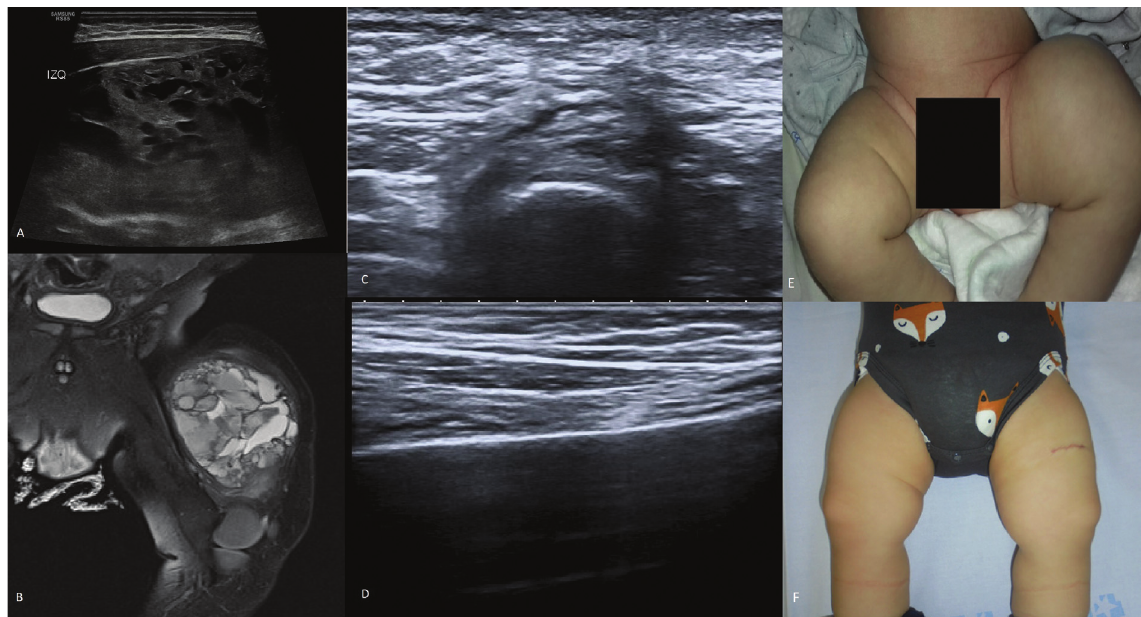
Fig. 2 (A) Ultrasound of the left lower limb with fi ndings suggestive of possible hematoma of the muscle. (B) MRI shows soft tissue tumor of the left lower limb. (C) and (D) demonstrate the absence of evidence of residual tumor on ultrasound. (E) Left lower limb pre-treatment. (F) Left lower limb after treatment, biopsy scar is